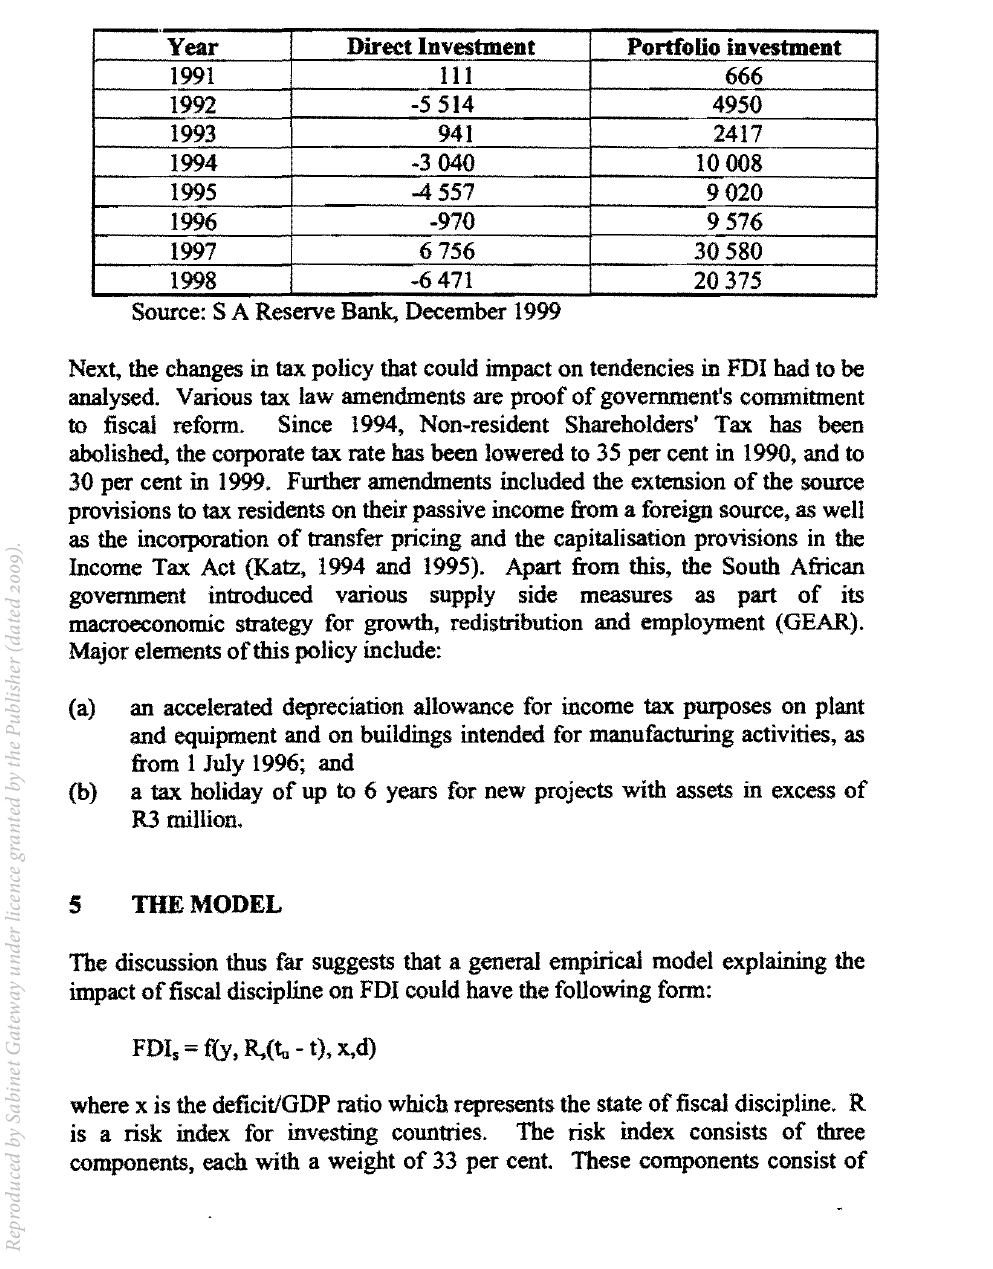
Direct and Portfolio Investment in South